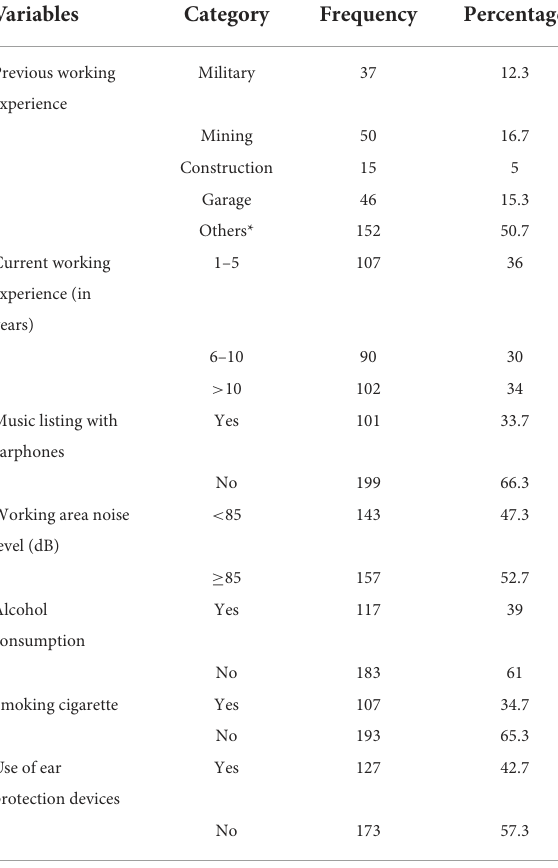
TABLE 2 Behavioral and work-related characteristics of study participants among metal workers in Gondar city, Northwest Ethiopia,